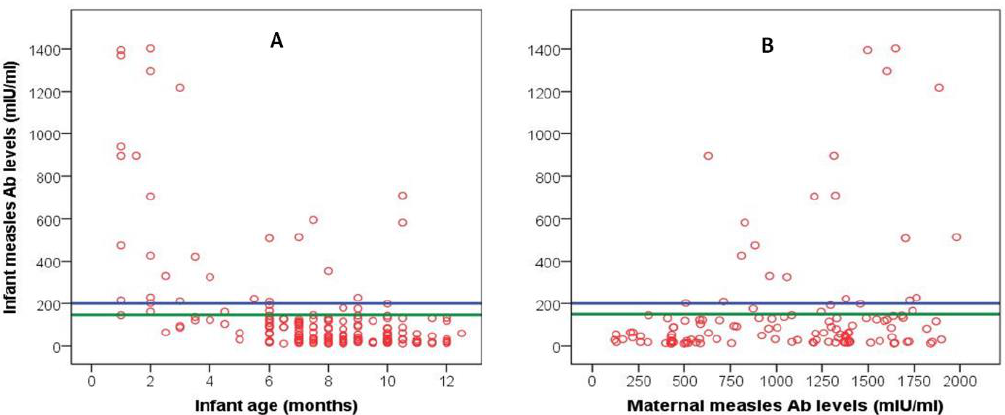
Figure 3. Scattergram of infant measles antibody levels plotted against infants’ age ( A ) and maternal antibody levels ( B ). The blue reference line represents the lower protective level (200 mIU/mL); the area between the blue and green reference lines represents the area of equivocal protective levels (150–200